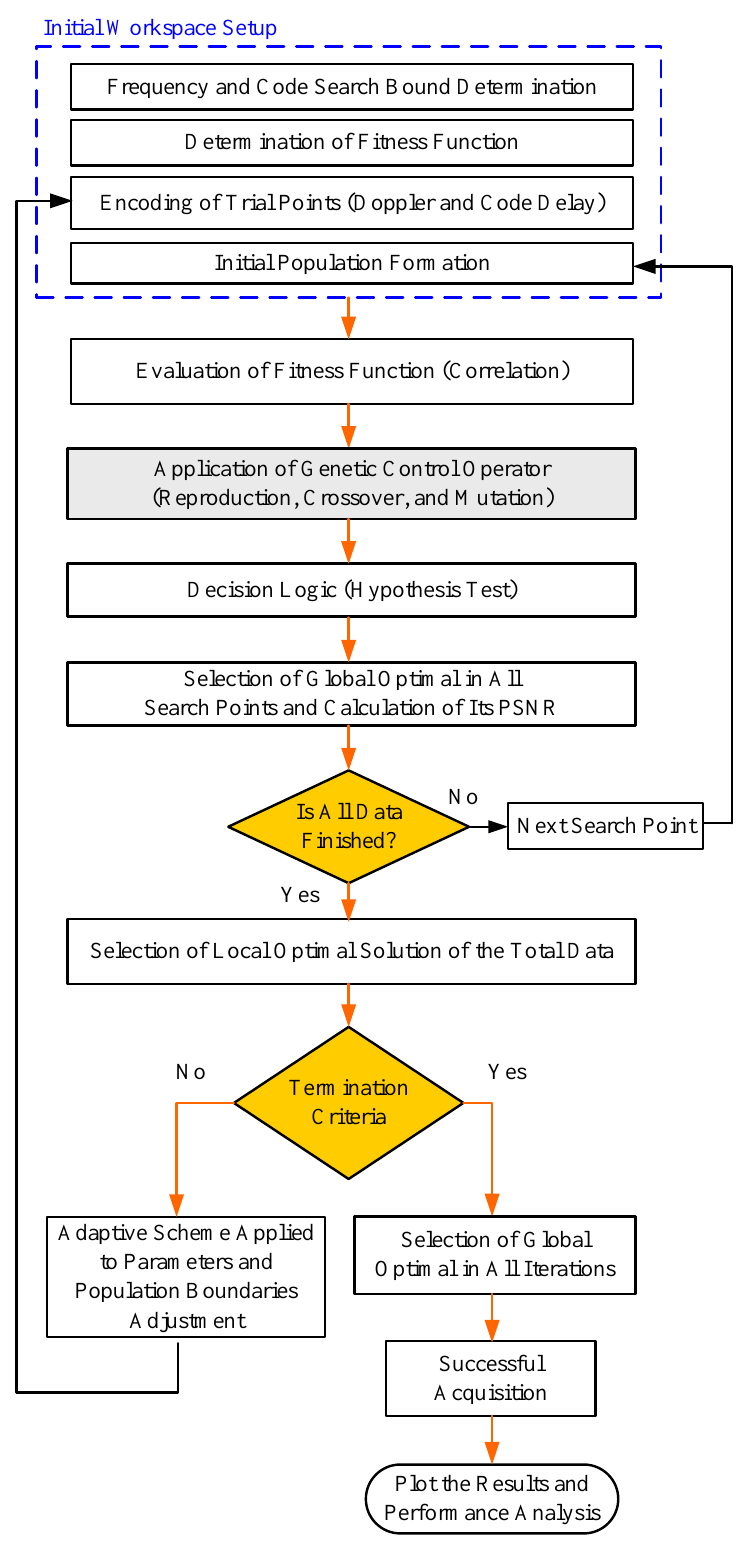
Figure 1. Flowchart of GC acquisition procedure with adaptive scaling scheme.